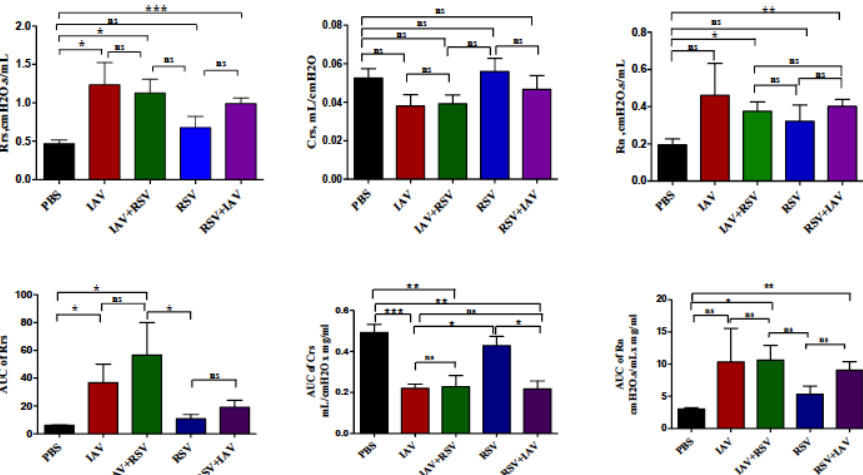
Figure 6. Lung function assessment on day 3 post-infection. Upper panels: Baseline airway reactivity expressed as thoracic resistance (Rrs), thoracic compliance (Crs) and large airway resistance (Rn). Lower panels: Methacholine responsiveness shown as “area under the curve” (AUC) of Rrs, Crs and Rn against methacholine concentration. The values are mean ± SEM. Two separate experiments ( n = 6) were performed. Asterisks denote statistically significant differences between experimental groups and the control group (* p < 0.05, ** p < 0.005, *** p < 0.0005). Two separate experiments ( n = 6) were performed; ns = not significant. Comparison among groups was performed using the nonparametric test (two independent variables: